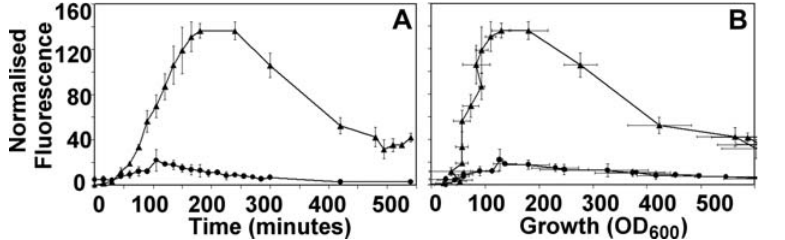
Figure 4. Experimental kinetics of GFP: In the Basic ( circles ) and the Delay ( triangles ) circuits upon induction in four independent experiments. (A) Normalised fluorescence versus time (minute); (B) Normalised fluorescence versus growth (OD 600 ). Error bars (one standard deviation) are for both fluorescence and growth.